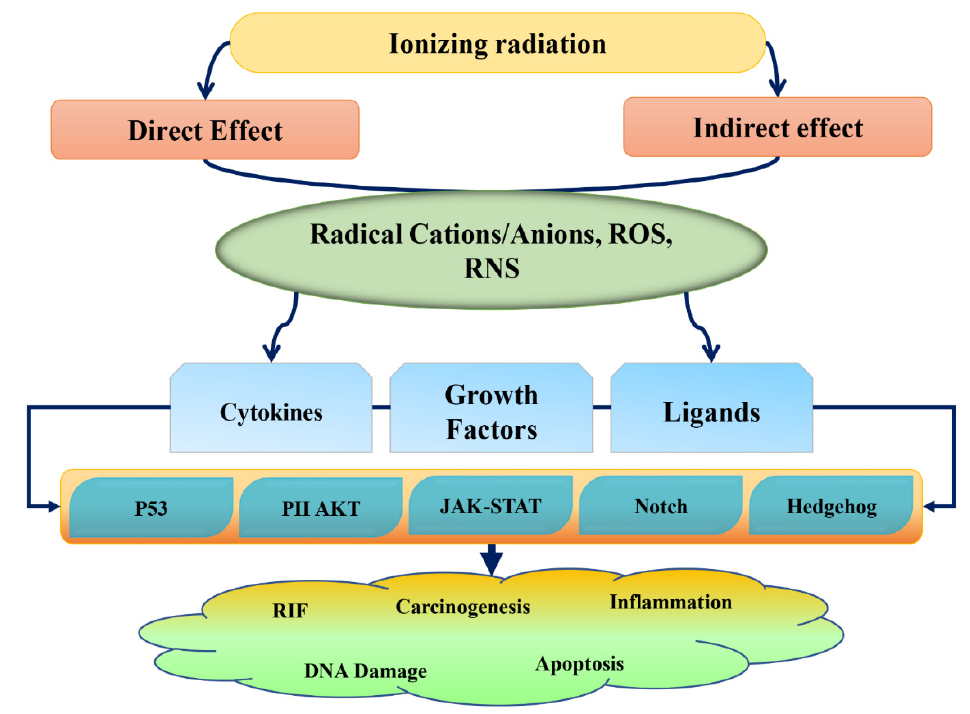
Figure 1. Effect of radiation on the biological systems .